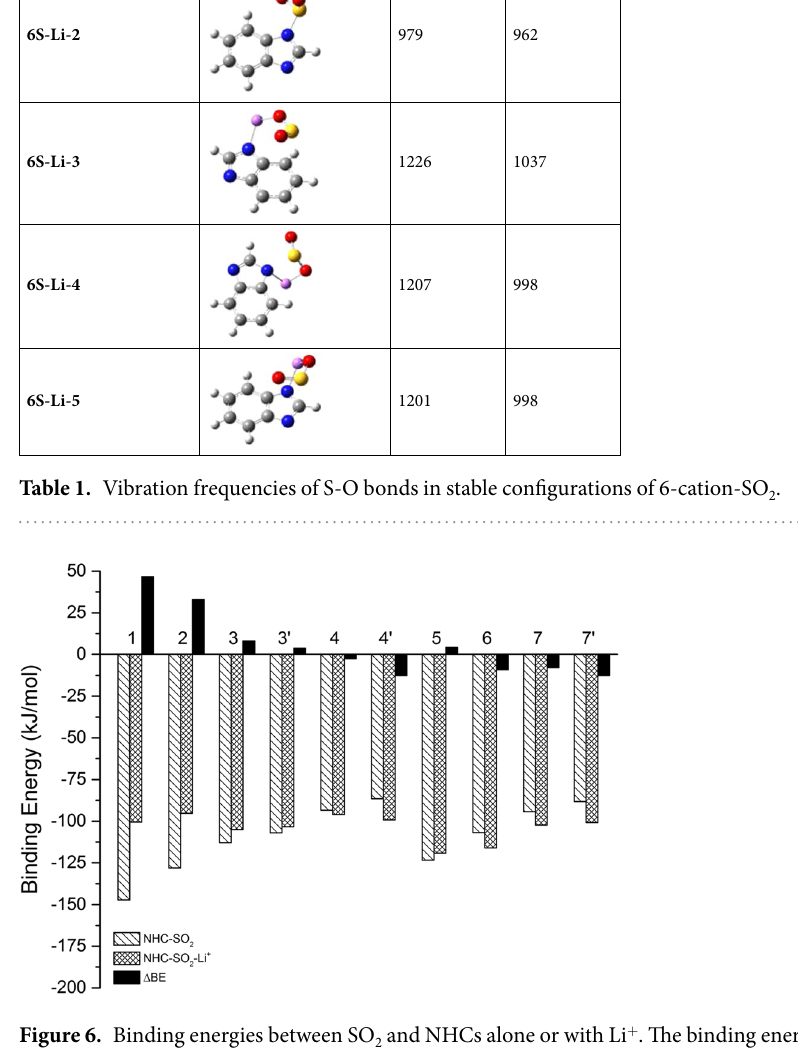
Figure 6. Binding energies between SO 2 and NHCs alone or with Li + . The binding energy differences are represented by filled black bars. Negative Δ BE means that the NHC-SO 2 interaction is strengthened by cation. Only the most stable configurations are used. For 3 , 4 and 7 , the reaction sites are on the N atom labelled as 1 in Fig. 1. For 3 ′ , 4 ′ and 7 ′ , the sites are at the N2